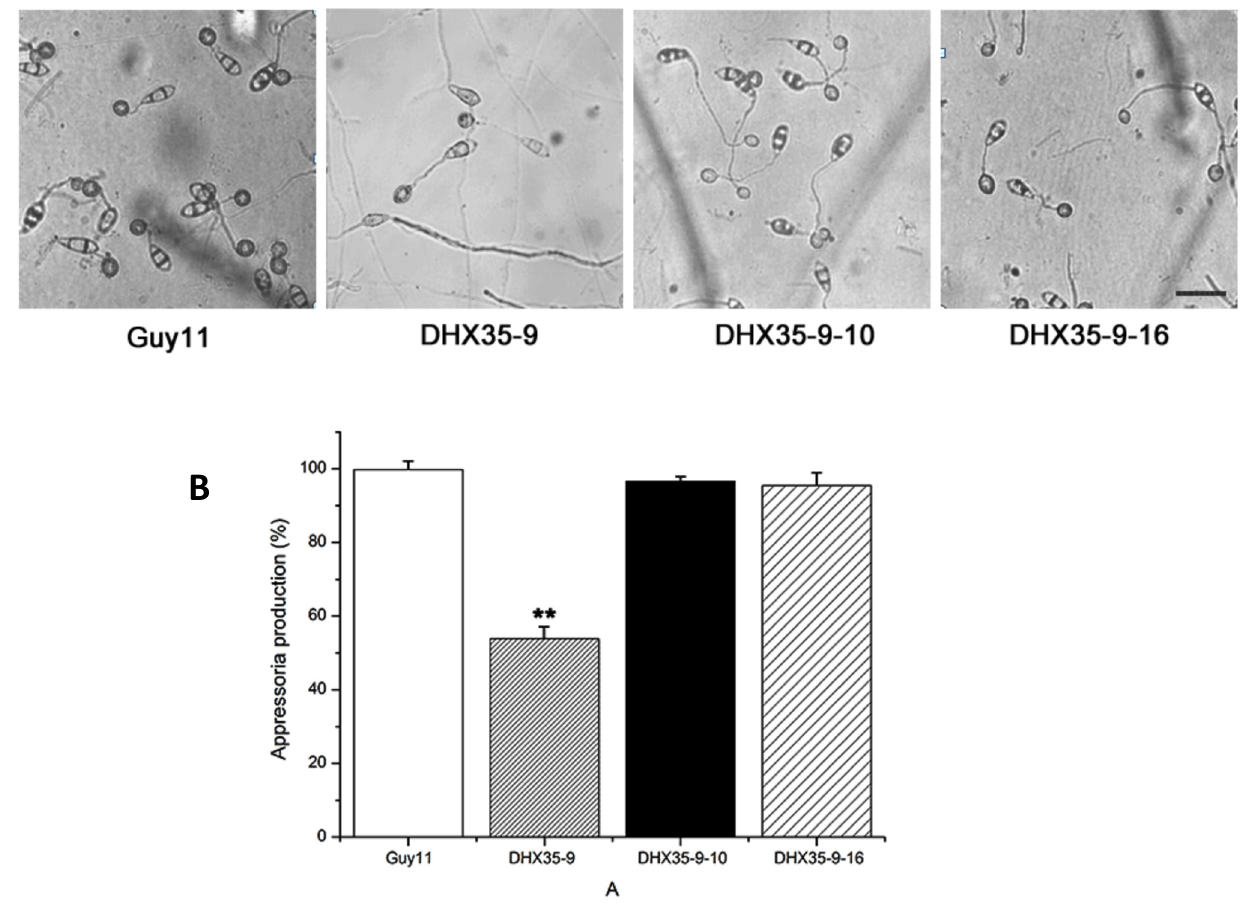
Figure 6. MoDHX35 is required in appressorial development. ( A ) Microscopy of the appressoria formed at 24 h post incubation on hydrophobic surface of the wild type, MoDHX35 -deleted mutant, and complement strains. The mutant was significantly reduced in its ability to form appressoria, and the appressoria of the mutant were less pigmented than those of the control strains. The bar = 20 µ m ( B ) The appressorial formation rates of MoDHX35 -deleted mutant, wild-type and complemented strains were calculated. The double asterisks indicate significant differences at p < 0.01 level.